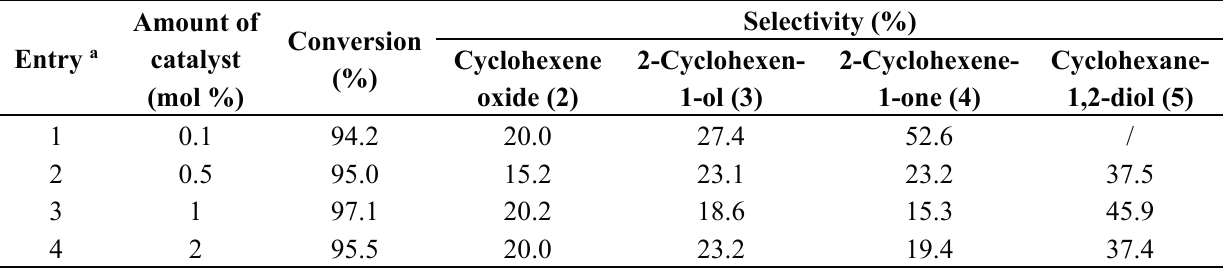
Table 5. The selective oxidation of cyclohexene to 1,2-diols catalyzed by iron (III) phthalocyanines with triflate as a counter anion by using H 2 O 2 as an oxidant at different